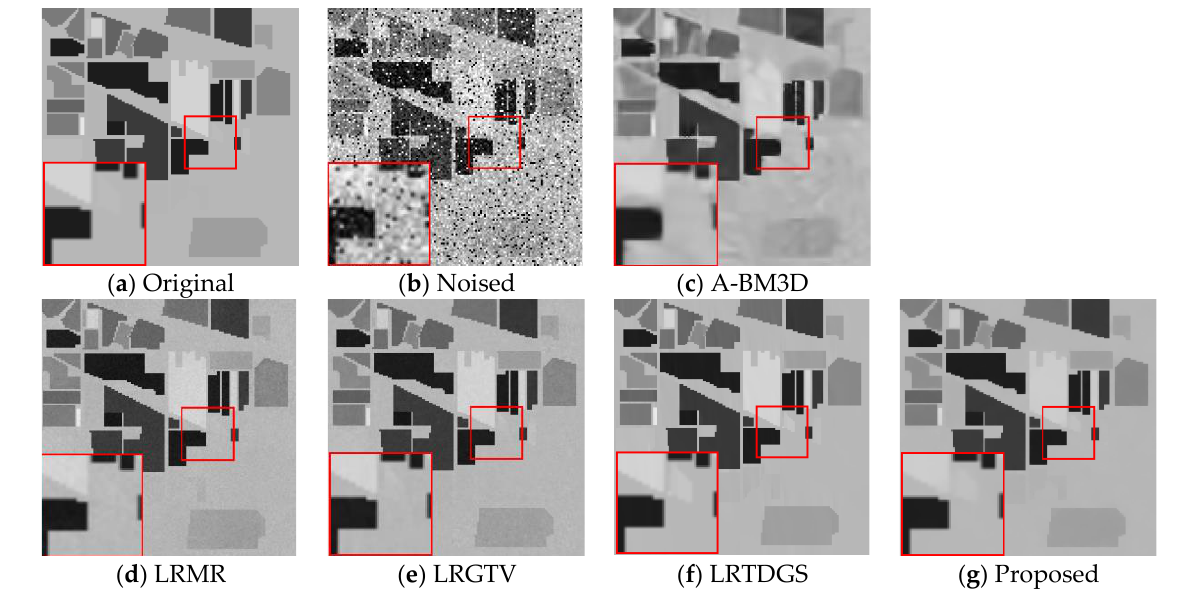
Figure 1. Restored results of band 35 on Simu–Indian. From top to bottom: the results under a subcase (the standard deviation of zero-mean Gaussian noise is G = 0.10, and the noise proportion of S&P noise is S = 0.10).